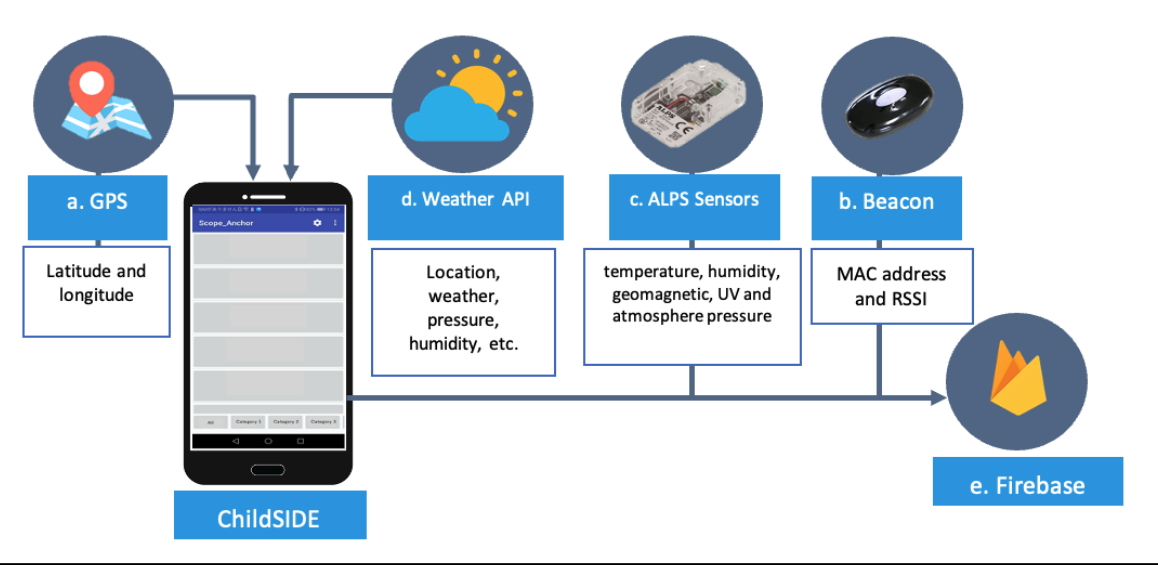
Figure 2. Data flow from the data sources (iBeacon, GPS, ALPS Sensors, and OpenWeatherMap API) detected and transmitted by ChildSIDE app to the Google Firebase database. API: application programming interface; RSSI: radio signal strength